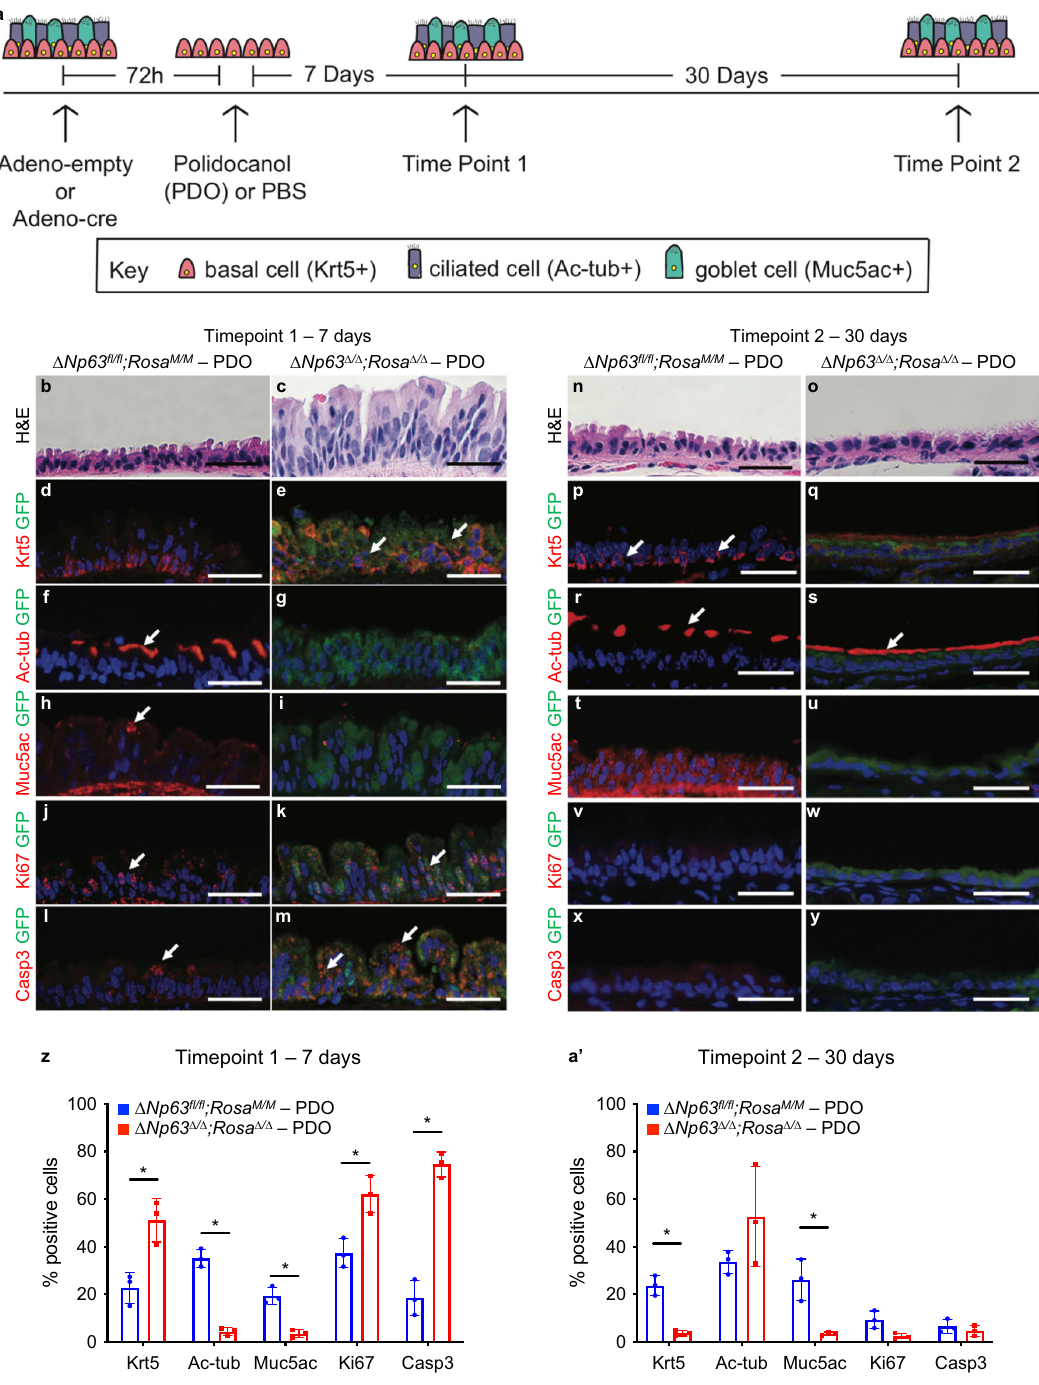
Fig. 3 Δ Np63 is required for the regeneration and terminal differentiation of the tracheal epithelium. a Schematic of polidocanol tracheal injury experiment. b , c Representative H&E stained cross-sections of Δ Np63 fl / fl ; Rosa M/M and Δ Np63 Δ / Δ ; Rosa Δ / Δ tracheal epithelia at 7 days post-PDO treatment. d – m Representative staining for Krt5/GFP ( d , e ), Ac-tub/GFP ( f , g ), Muc5ac/GFP ( h , i ), Ki67/GFP ( j , k ) and Casp3/GFP ( l , m ) in the same tracheal epithelia shown in b , c . n , o Representative H&E stained cross-sections of Δ Np63 fl / fl ; Rosa M/M and Δ Np63 Δ / Δ ; Rosa Δ / Δ tracheal epithelia at 30 days post-PDO treatment. p – y Representative staining for Krt5/GFP ( p , q ), Ac-tub/GFP ( r , s ), Muc5ac/GFP ( t , u ), Ki67/GFP ( v , w ) and Casp3/GFP ( x , y ) in the same tracheal epithelia shown in ( n , o ). All scale bars equal 100 µ m. z Quanti fi cation of the staining for Krt5, Ac-tub, Muc5ac, Ki67 and Casp3 for Δ Np63 fl / fl ; Rosa M/M and Δ Np63 Δ / Δ ; Rosa Δ / Δ tracheal epithelia at 7 days post-PDO treatment. Data were mean ± SD, n = 3, * vs. Δ Np63 fl / fl ; Rosa M/M , P < 0.05, two- tailed Student ’ s t -test. a ′ Quanti fi cation of the staining for Krt5, Ac-tub, Muc5ac, Ki67 and Casp3 for Δ Np63 fl / fl ; Rosa M/M and Δ Np63 Δ / Δ ; Rosa Δ / Δ tracheal epithelia at 30 days post-PDO treatment. Data were mean ± SD, n = 3, * vs. Δ Np63 fl / fl ; Rosa M/M , P < 0.05, two-tailed Student ’ s t -test. Source data are provided as a Source Data fi